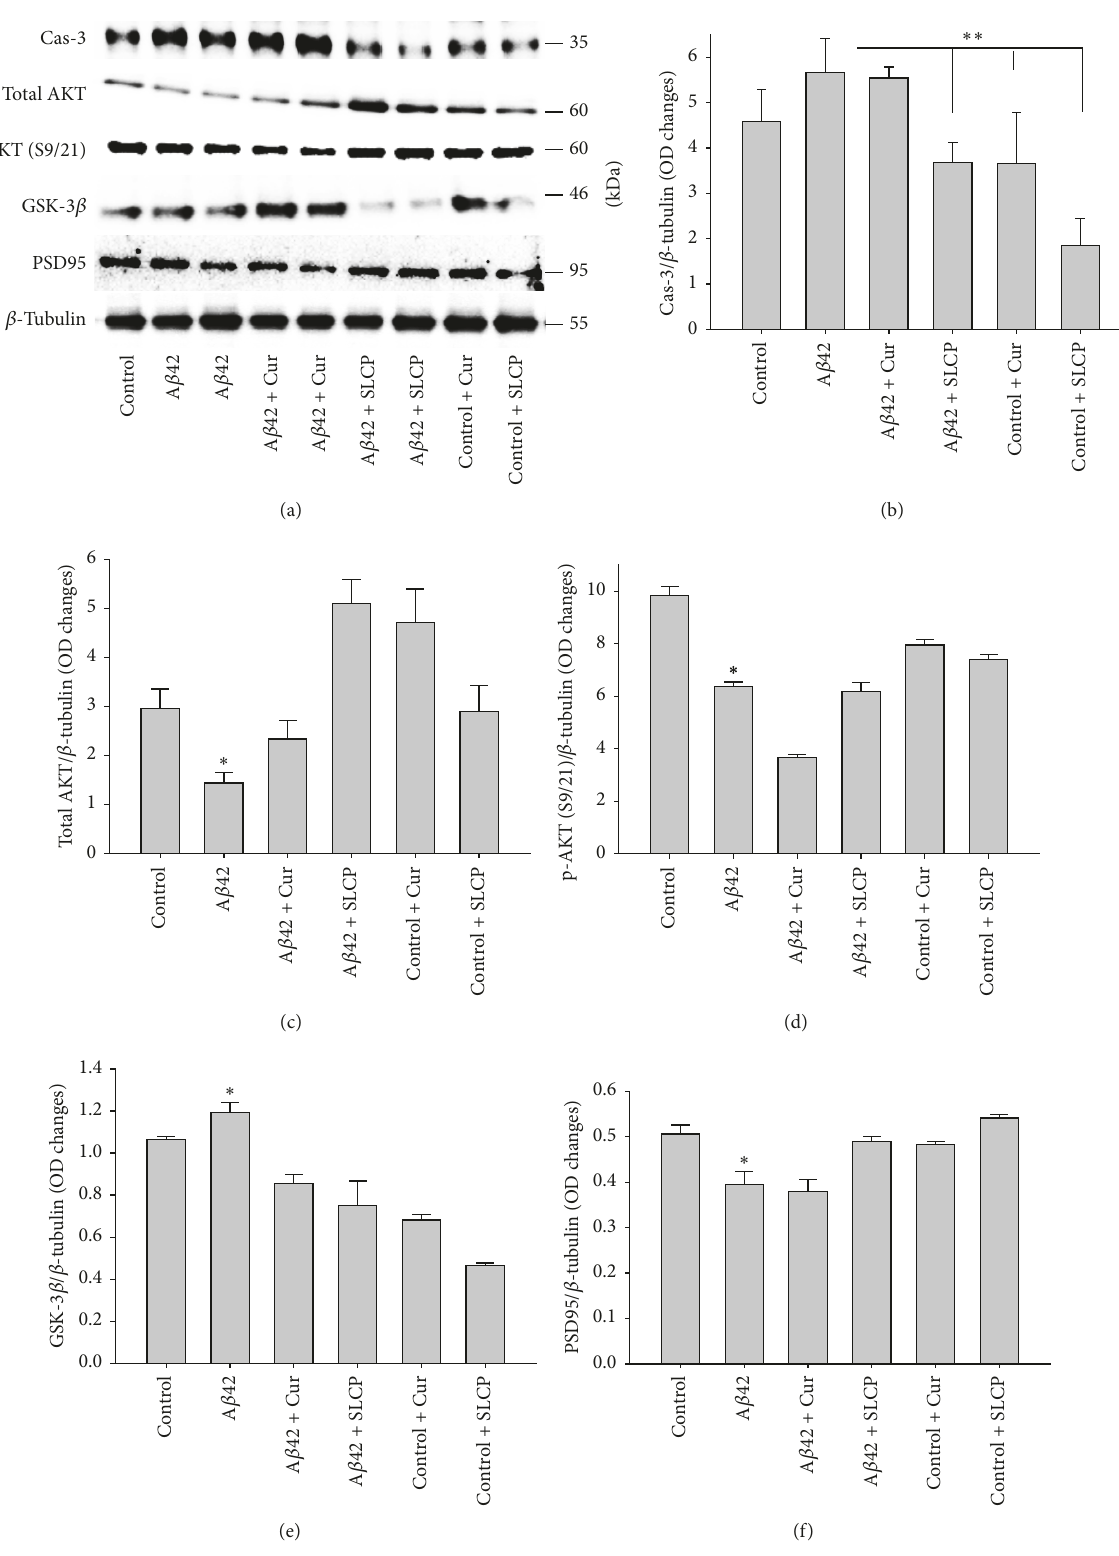
Figure 5: Cell survival markers proteins were enhanced by dietary Cur and/or SLCP after exposure to A 𝛽 42. N2a cells were treated with A 𝛽 42 (10 𝜇 M) for 24 h in absence or presence of dietary Cur and SLCP (1 𝜇 M). Western blot data indicated a significant increase in Cas-3 (b) and GSK-3 𝛽 (e), with decreases in total Akt level (c), p-Akt (c and d), and PSD9 (f), whereas Cur and/or SLCP ameliorated these effects. ∗∗ 𝑝 < 0.01 and ∗ 𝑝 < 0.05 in comparison to group treated only with A 𝛽